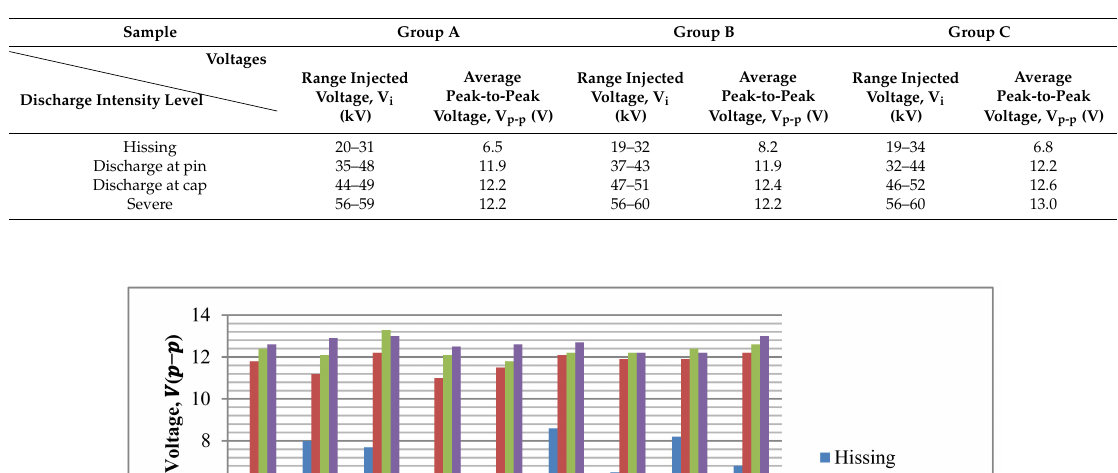
Table 11. Injected voltage and average peak-to-peak voltages of the UV signals for dry insulators conditions with heavy contamination level.